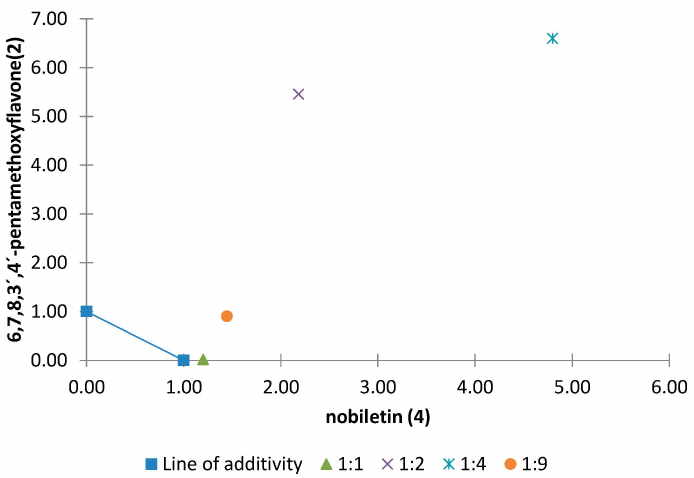
Figure 12. Normalized isobologram (ED 25 ) for the binary mixture nobiletine ( 4 )/6,7,8,3 1 ,4 1 -pentamethoxyflavone ( 2 ) in the etiolated wheat coleoptile bioassay. (Combination ratios 1:1; 1:2; 1:4; 1:9). The ratio of 1:1 did not show any significant difference on applying Student’s